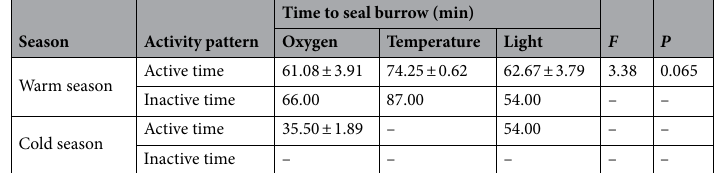
Table 4. Burrow-sealing latency in the field under different